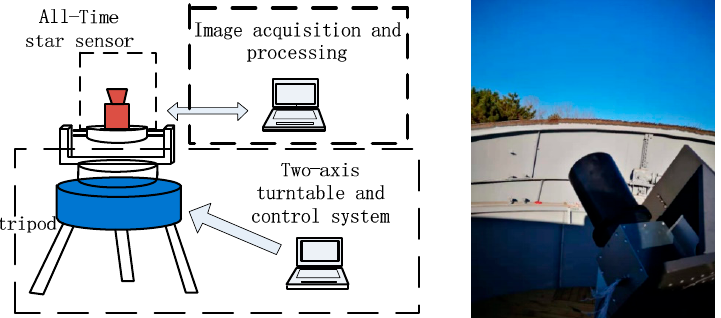
Figure 9. Daytime sky experiment.